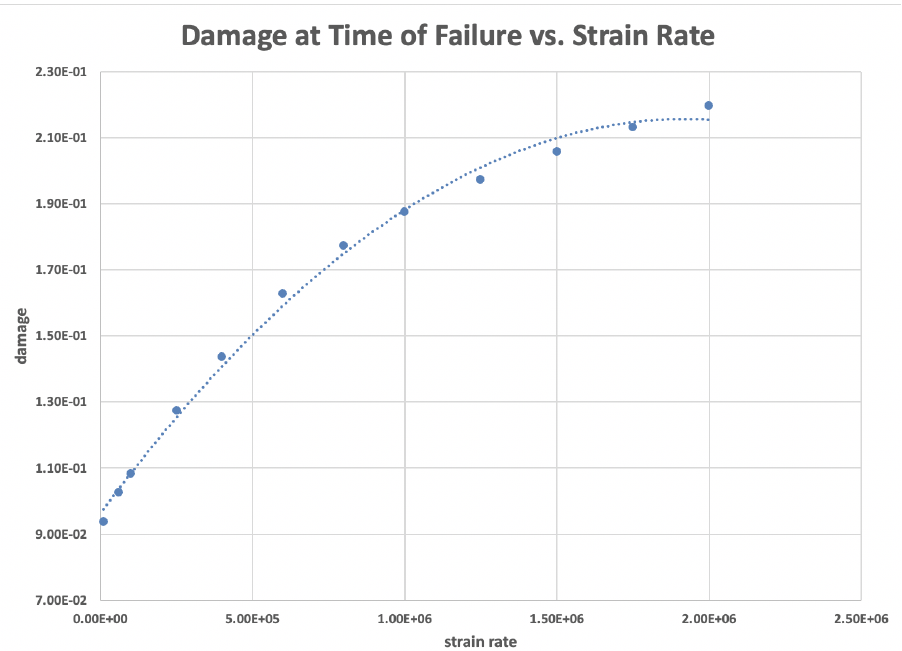
Figure 4. The damage at the time of failure is plotted as a function of strain rate. The ensemble size is 100 and the process zone is 10% of the crack radius. Higher strain rates lead to more damage sustained at the time of failure. The curve is captured by a quadratic trendline with R 2 =